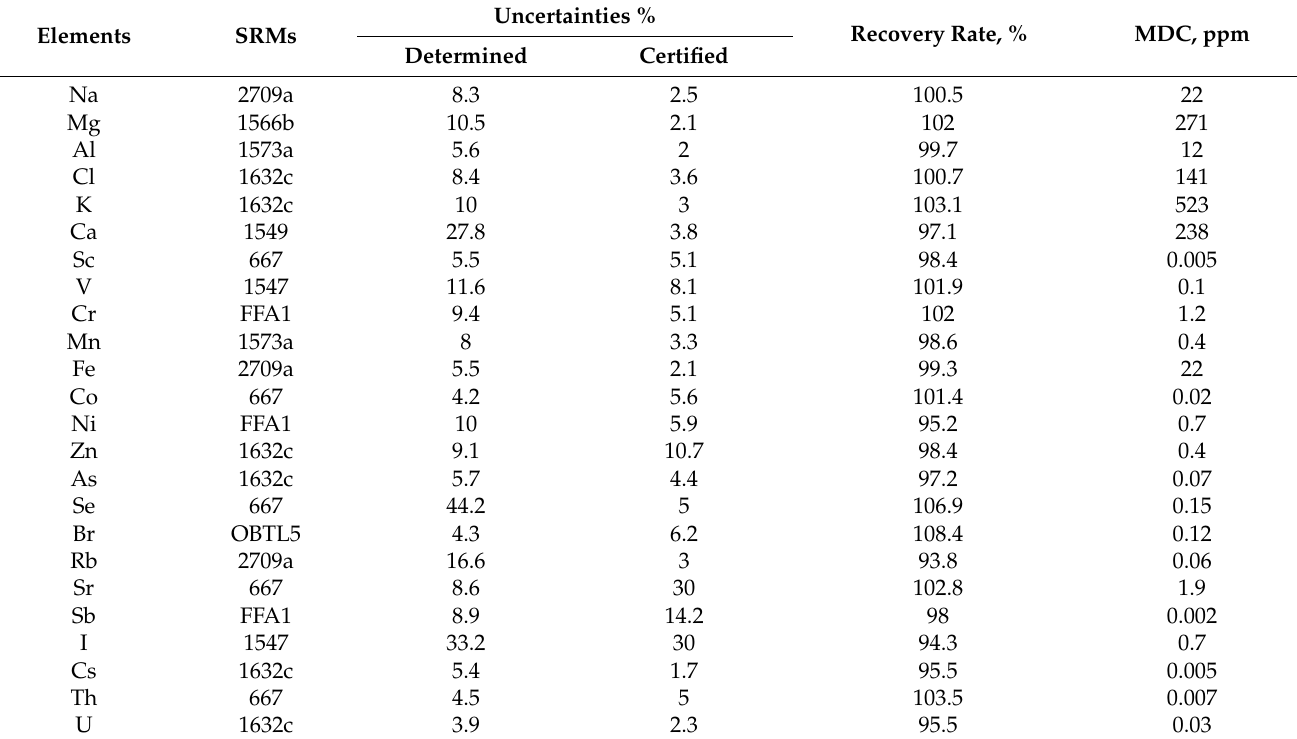
Table 1. Quality control of neutron activation